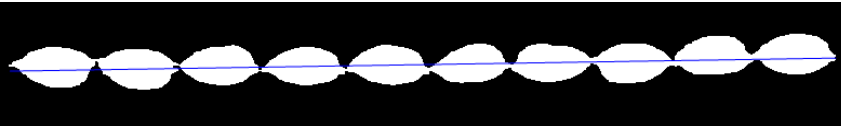
Figure 6. Binary image of rice grains without overlap and its main axis.